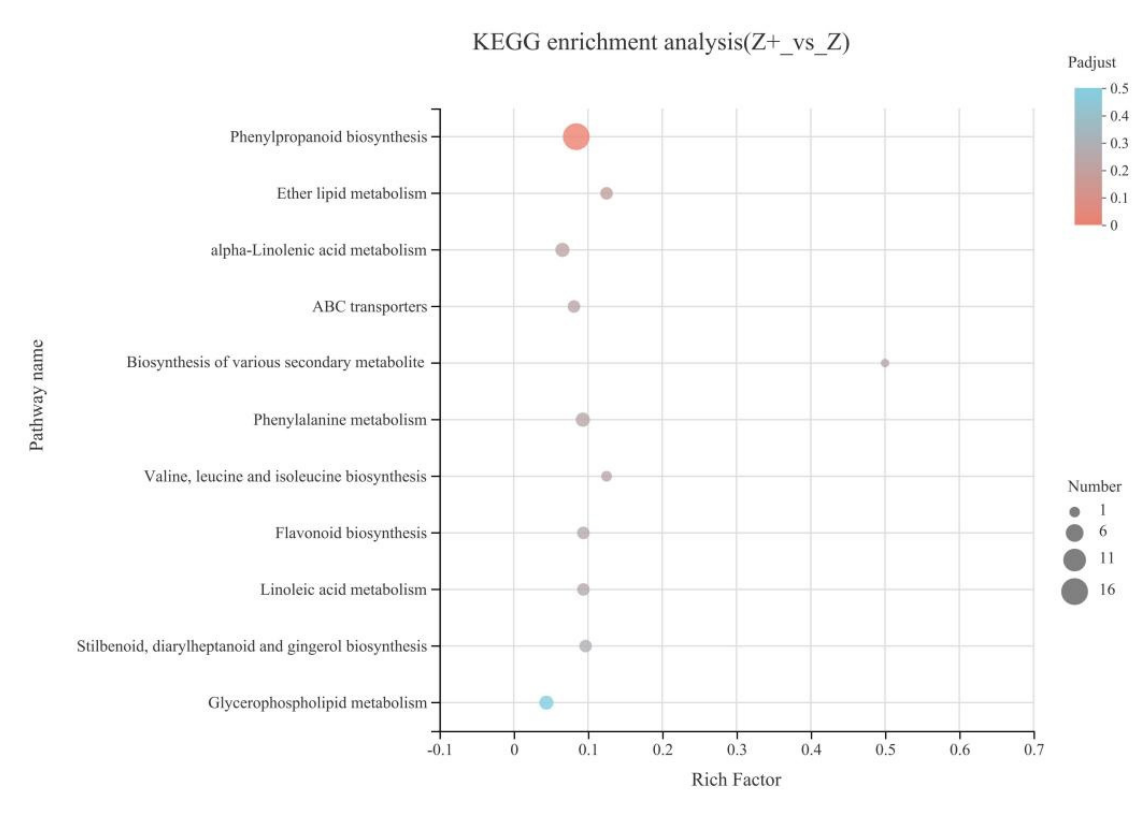
Figure 4. KEGG enrichment analysis of DEGs for the comparison of self-rooted cucumber with silicon addition (Z+) and self-rooted cucumber (Z), and “Benjamini and Hochberg” test was used to detect significantly enriched KEGG terms (FDR < 0.05, p <